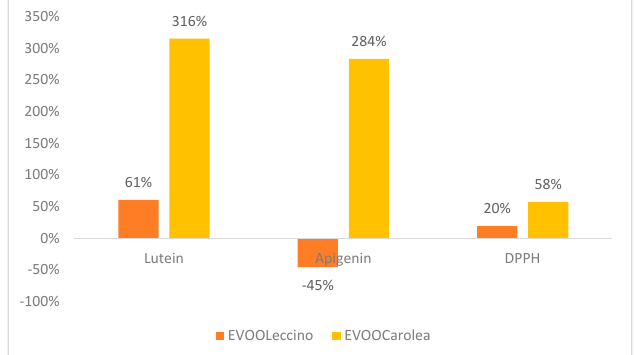
Figure 5. Variation (%) of flavonoids and antioxidant activity measured by DPPH test in EVOOs obtained from olive tree treated with HA.